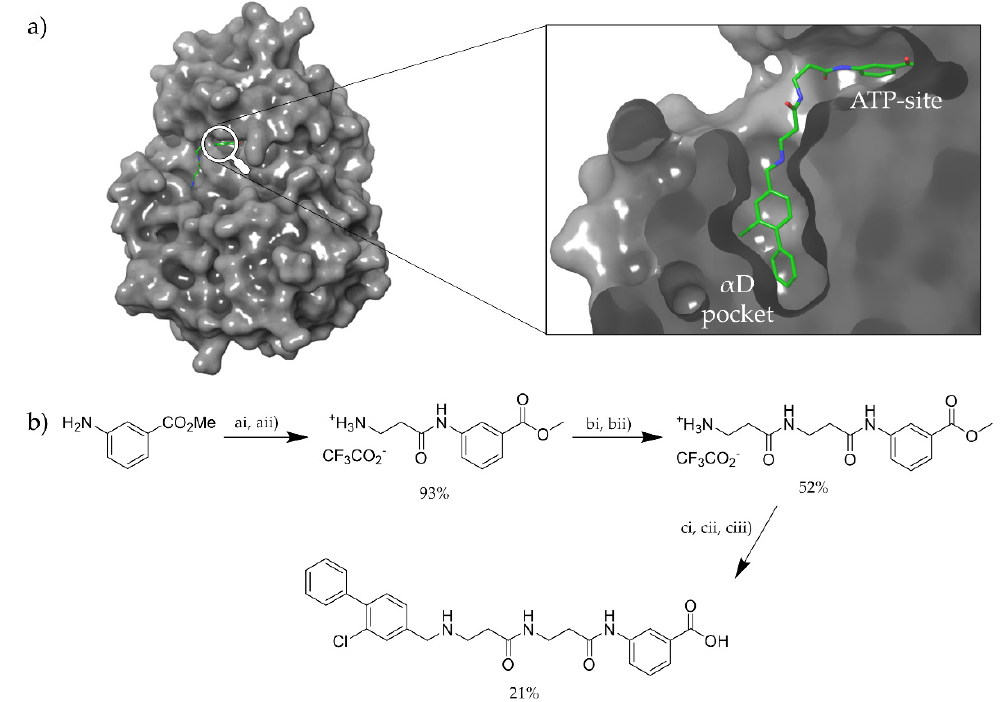
Figure 13. ( a ) Structure of CAM4066 bound to CK2 α , spanning the α D pocket and the ATP-site (PDB: 5CU3). ( b ) Synthesis of CAM4066; ( ai ) boc- β -Ala, DCC, DMAP, CH 2 Cl 2 , 16 h; ( aii ) TFA/CH 2 Cl 2 , 30 min; ( bi ) boc- β -Ala, HATU, DMAP, DMF, 16 h; ( bii ) TFA/CH 2 Cl 2 , 30 min; ( ci ) 2-chloro-[1,1 ′ -biphenyl]-4-carbaldehyde, Na(AcO) 3 BH, Et 3 N, MeOH, 18 h; ( cii ) LiOH, H 2 O/THF, 2 h; ( ciii ) 4 M HCl in dioxane, 10 min [102].